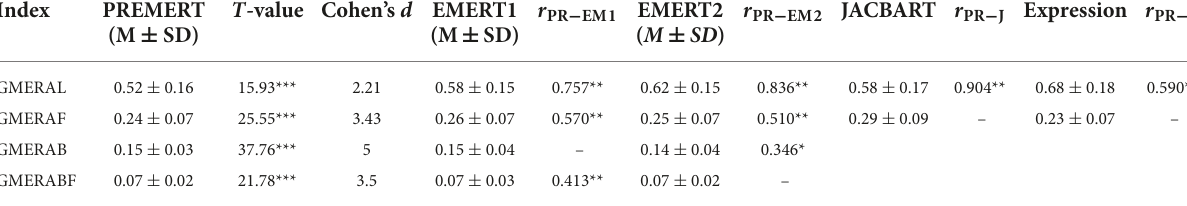
TABLE 3 The indicators of the